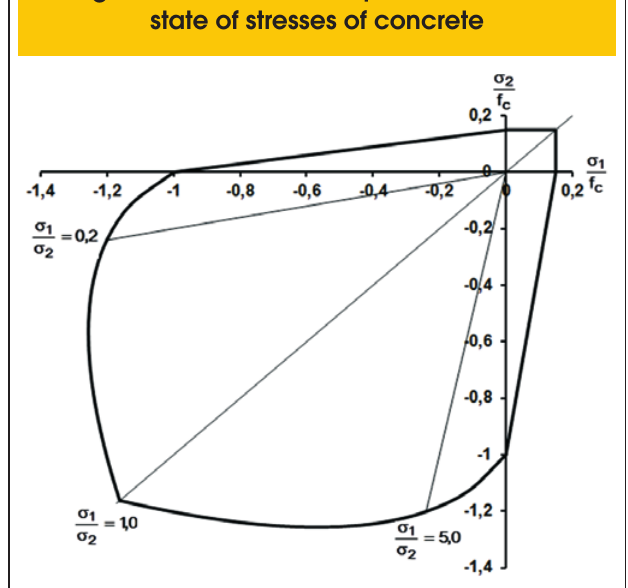
Figure 2 – Failure envelope to the biaxial state of stresses of